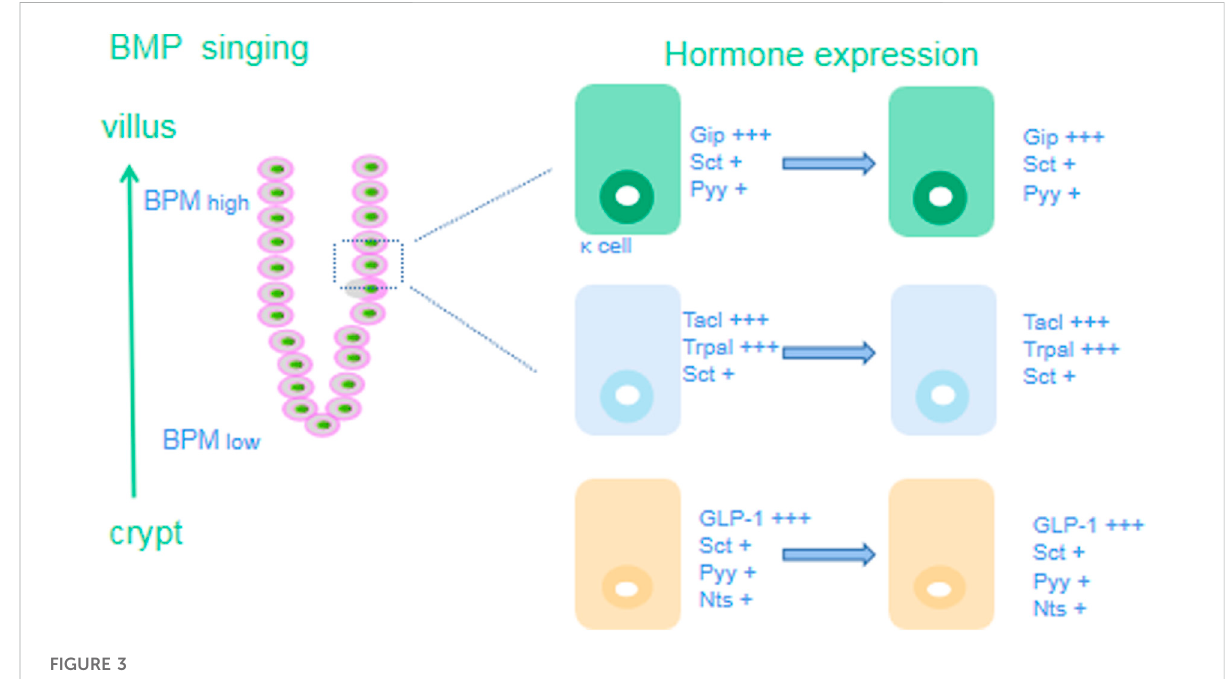
FIGURE 3 Notch signaling